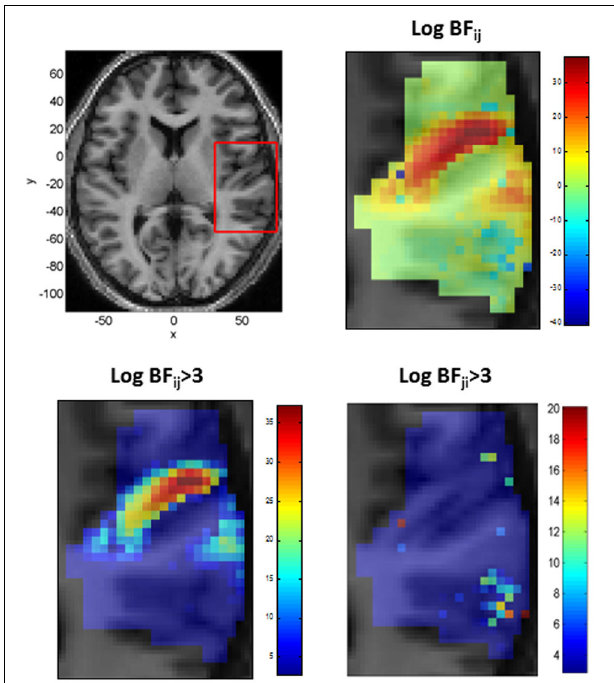
FIGURE 9 | Top Left: Axial slice of structural image at z = 6 with bounding box showing region displayed on other three panels (x, y, and z denote MNI coordinates in mm), Top Right: Log Bayes factor for Gaussian versus Mexican-Hat NRFs (full range of values). Positive values provide evidence for the Gaussian and negative values for the Mexican-Hat NRF. Bottom Left: As top right but scale changed to range log BF ij > 3. Bottom Right: A plot of log BF ji over range log BF ji > 3 (i.e., in favor of Mexican-Hat). The Mexican-Hat is favored in a posterior region, and the Gaussian more